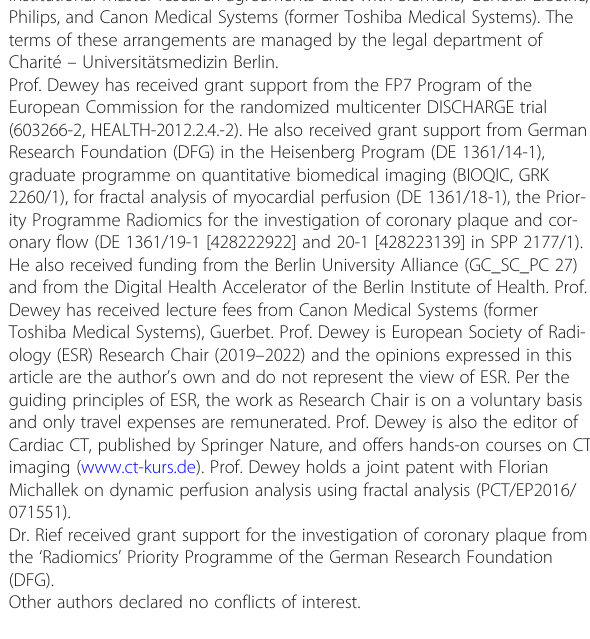
Supplementary Table 2. Scan timing of static myocardial CT perfusion during arterial contrast medium first pass. Supplementary Table 3. All patients: direct comparison of the results of MSR and HSR of myocardial CTP. Supplementary Table 4. Patient subgroups in per-patient level analysis: direct comparison of the results of MSR and HSR of myocardial CTP. Supplementary Table 5. Patient subgroups in per-territory level analysis: direct comparison of the results of MSR and HSR of myocardial CTP. Supplementary Table 6. All patients using ≥ 70% stenosis as refer- ence: diagnostic performance of MSR and HSR of myocardial CTP. Sup- plementary Table 7. Patient subgroups in per-patient level